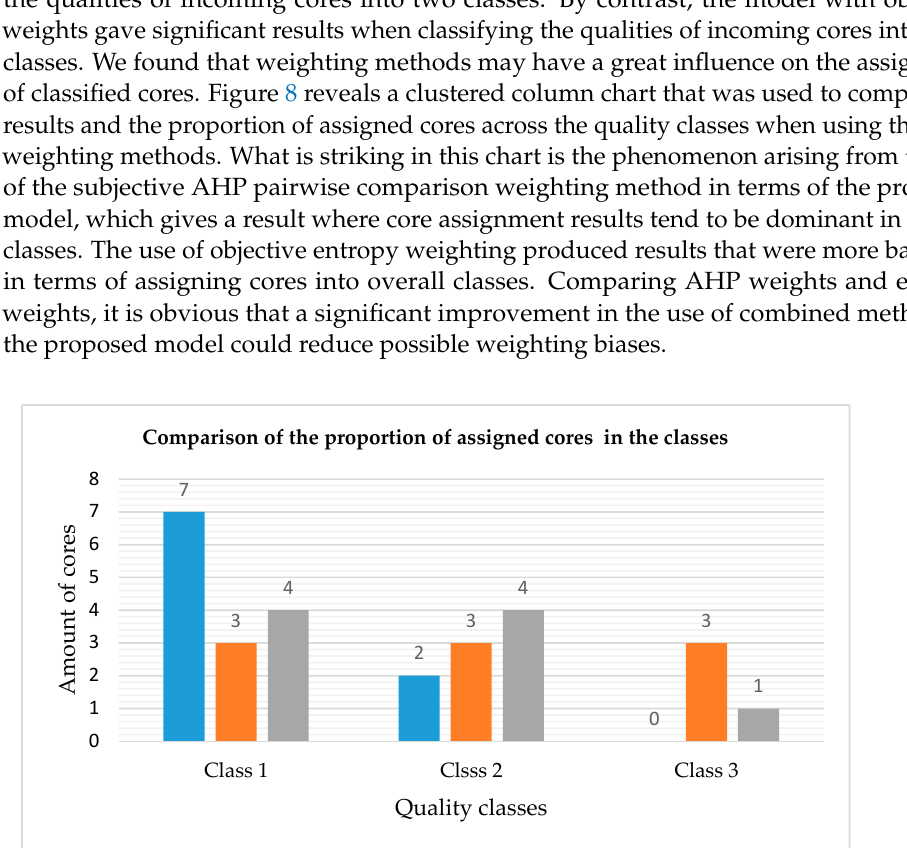
(cid:16) (cid:17) σ j s based on combined weights.